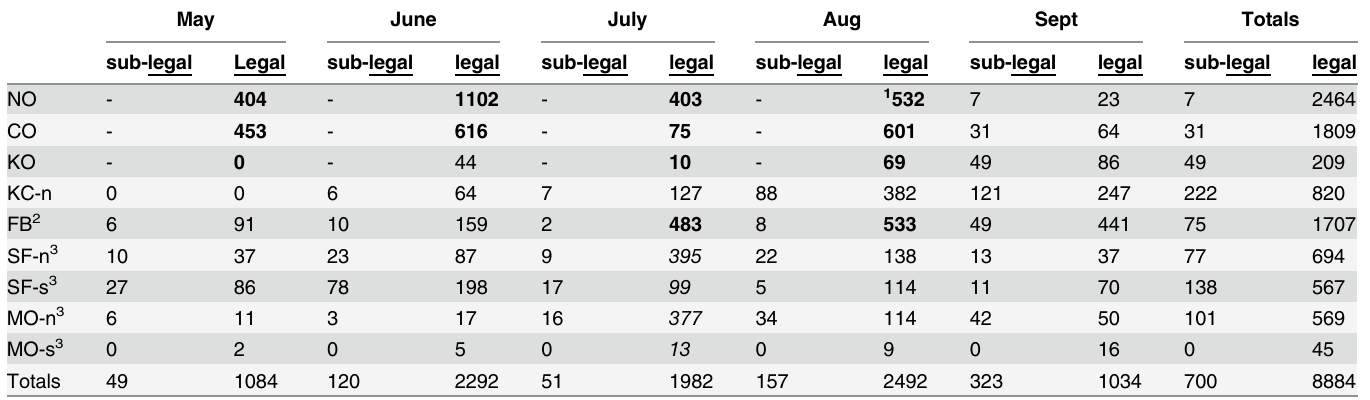
Table 2. Numbers of sub-legal and legal-sized Chinook salmon